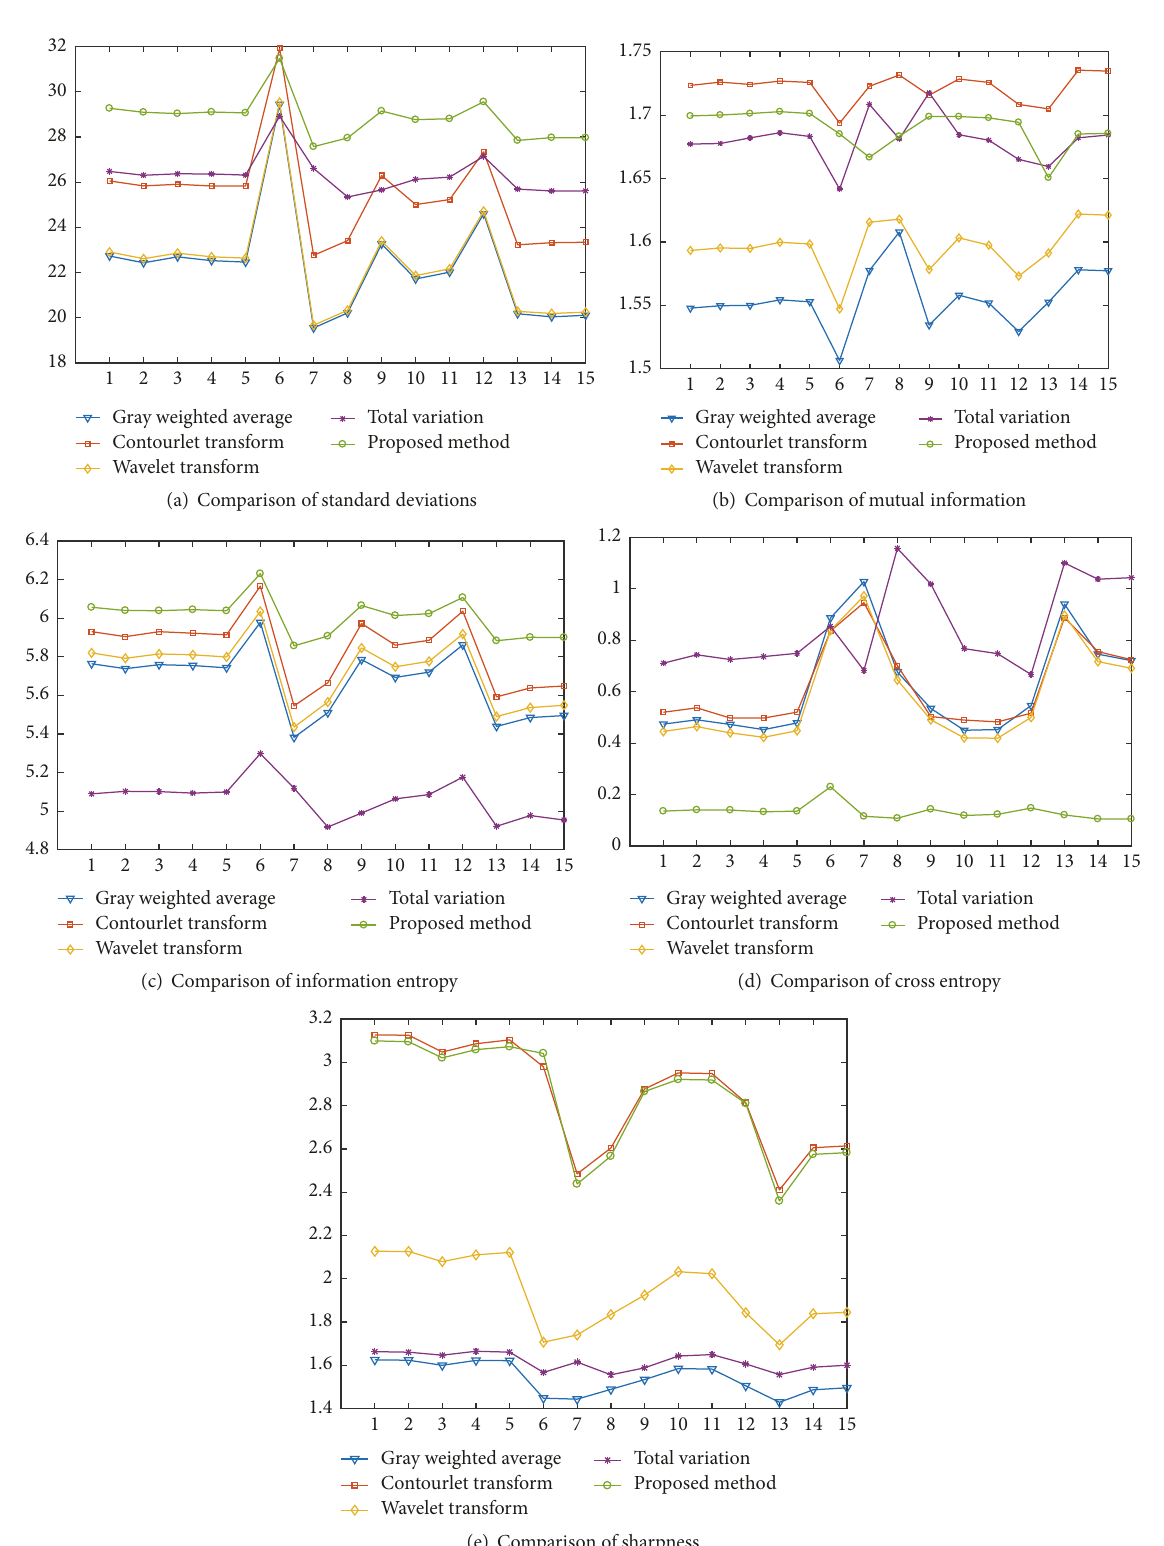
Figure 13: Quantitative evaluation of night images